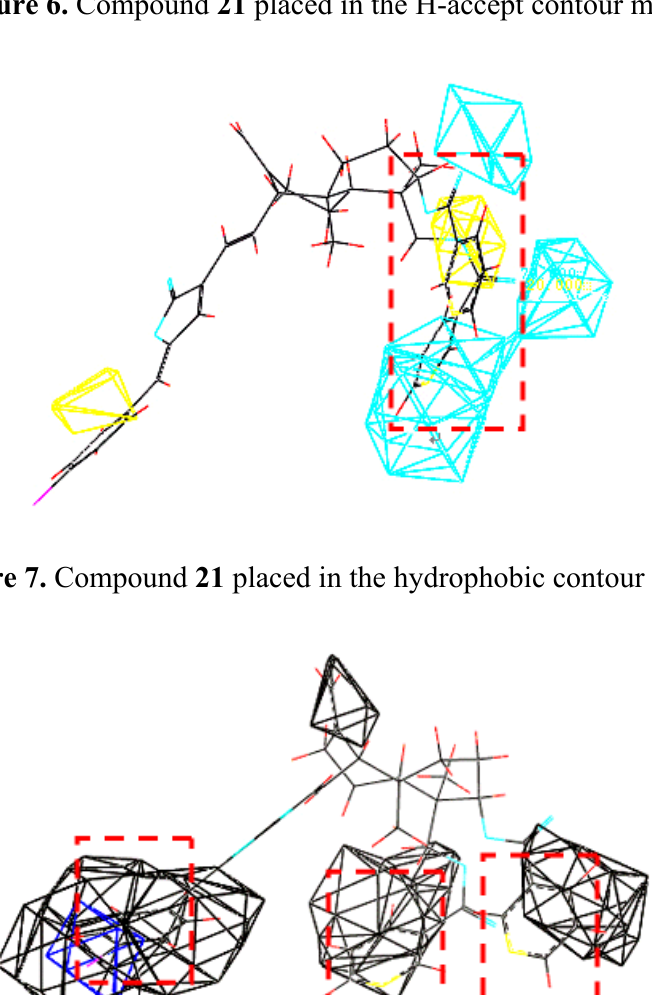
Figure 6. Compound 21 placed in the H-accept contour map.